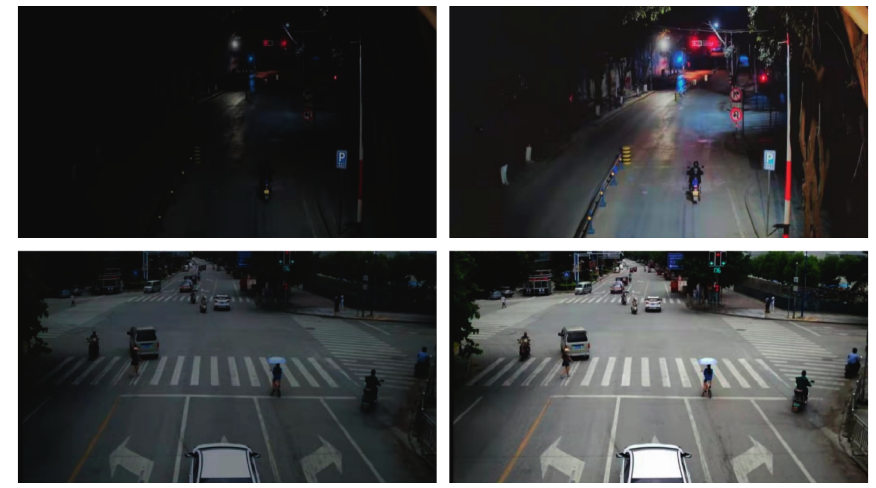
Figure 7: Effect drawing of Laplace